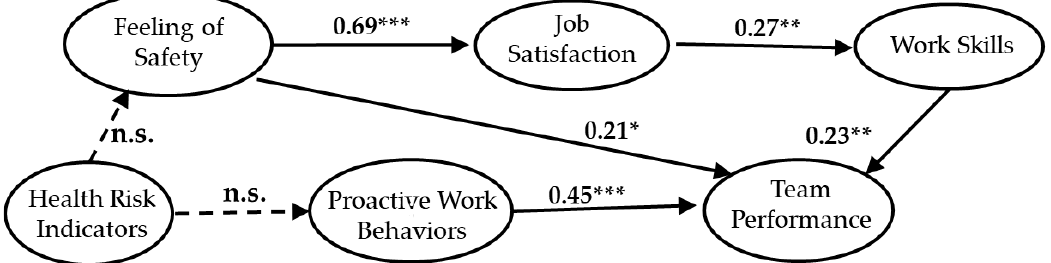
Figure 3. Standardized parameter estimates for the final structural model of young workers. * indicates p < 0.05; ** indicates p < 0.01; *** indicates p < 0.001; n.s.: not significant. The path coefficient is a standardized estimate value.